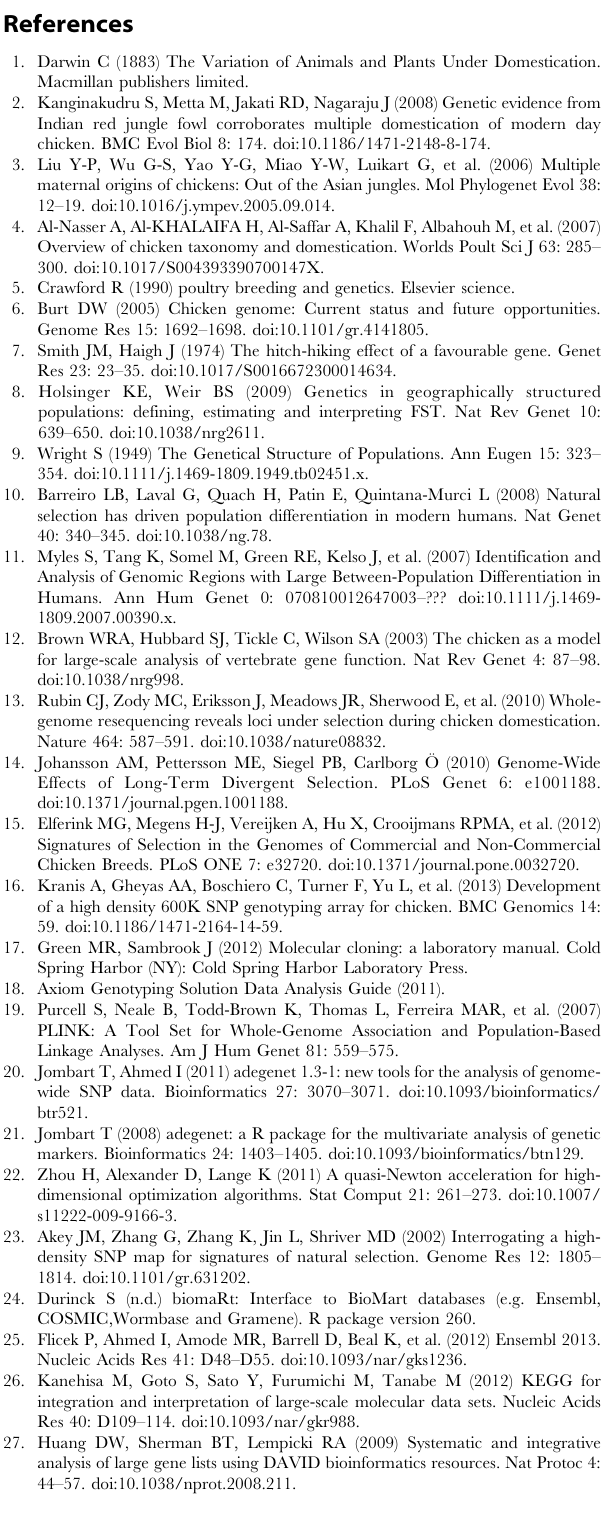
Table S7 List of pathways and gene ontologies in lower 1% FST distribution in comparison of brown layers and white layers. Table S8 List of pathways and gene ontologies in upper1% FST distribution in comparison of brown layers and white